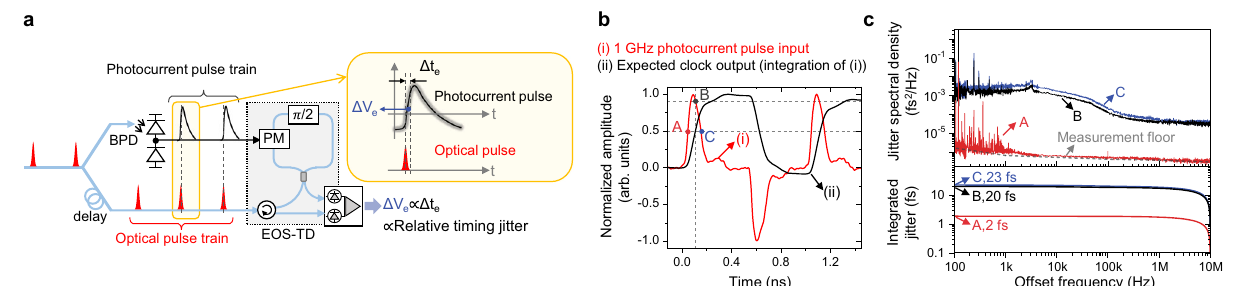
clock waveforms. c Measured timing jitter power spectral densities at different locations (corresponds to points A, B, and C in Fig. 4b) of photocurrent pulses.